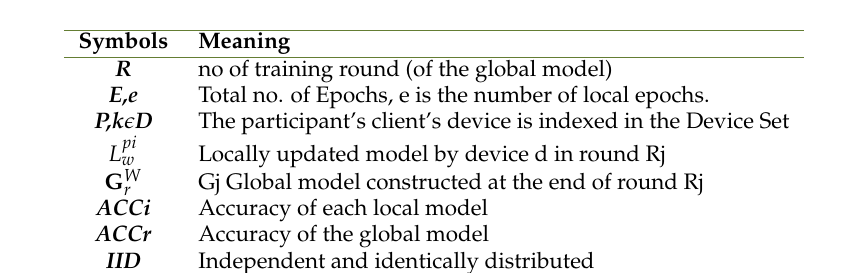
Table 2. List of Notations.